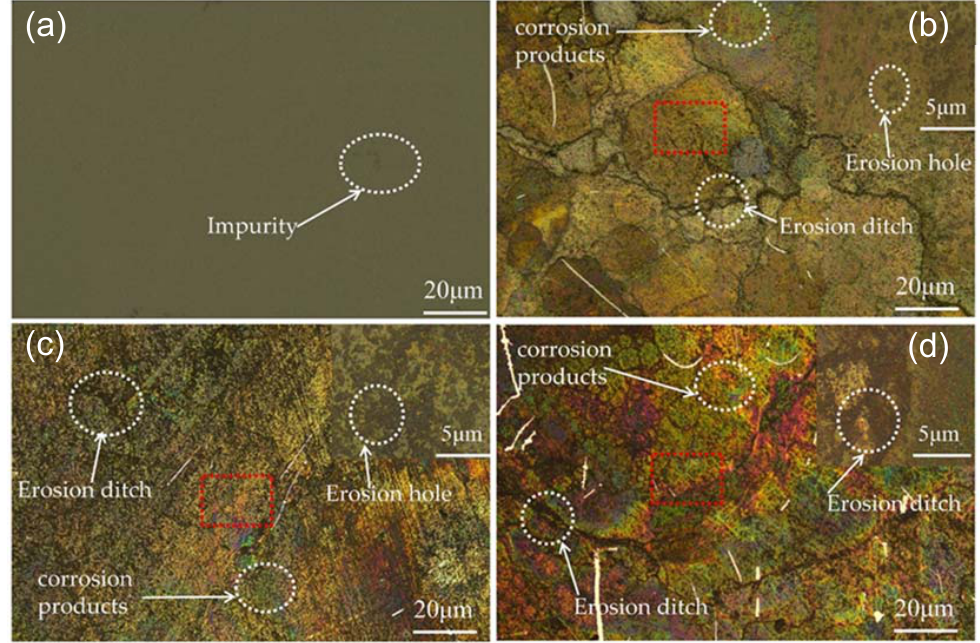
Figure 6. ( a ) Uncorroded sample surface, ( b ) sample surface after 12 h of corrosion, ( c ) sample surface after 24 h of corrosion, ( d ) sample surface after 36 h of corrosion. Table 5. Sample mass before and after corrosion. Sample